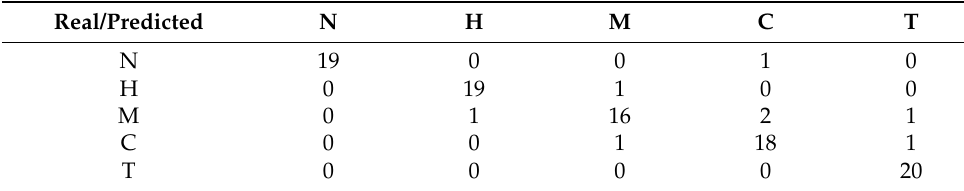
Table 5. Confusion matrix for the algorithm with the highest accuracy,